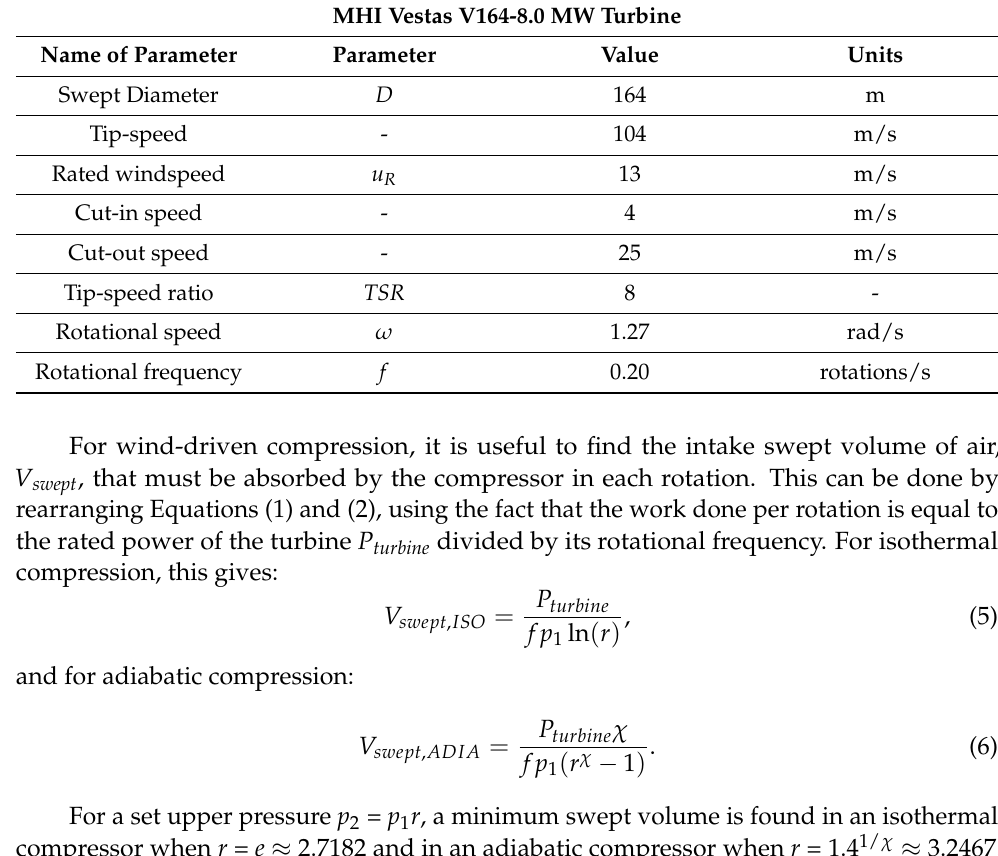
Table 1. Data for reference turbine used in this paper. From